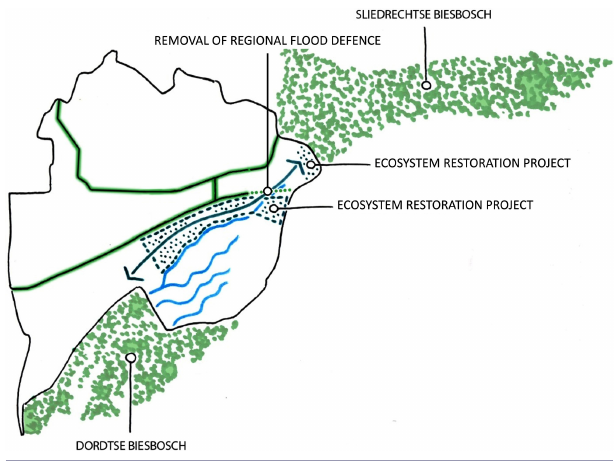
Fig. 6 . Proposed opening in the regional flood defence,